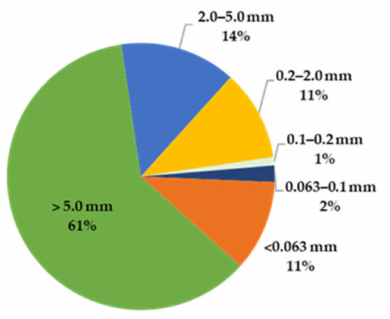
Figure 3. The percentage weight distribution of size fractions from the soil washing test.